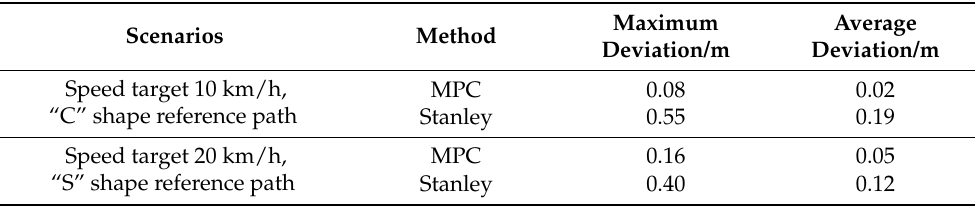
Figure 14. Vehicle wheel angle of MPC control and Stanley control.